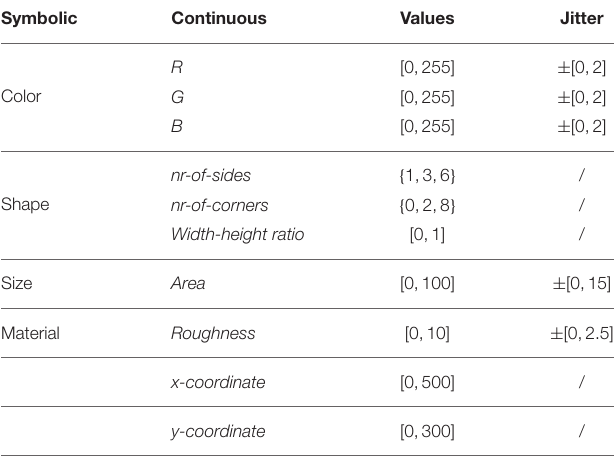
TABLE 2 | Rules used to transform symbolic object properties to continuous-valued attributes.